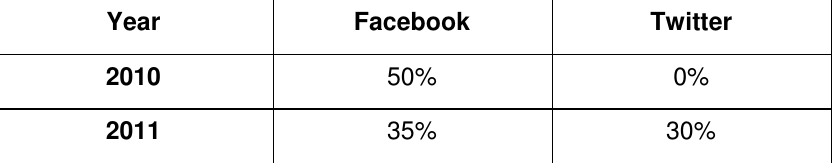
Table 2: Facebook and Twitter Enquiry Response Rates by Candidates,